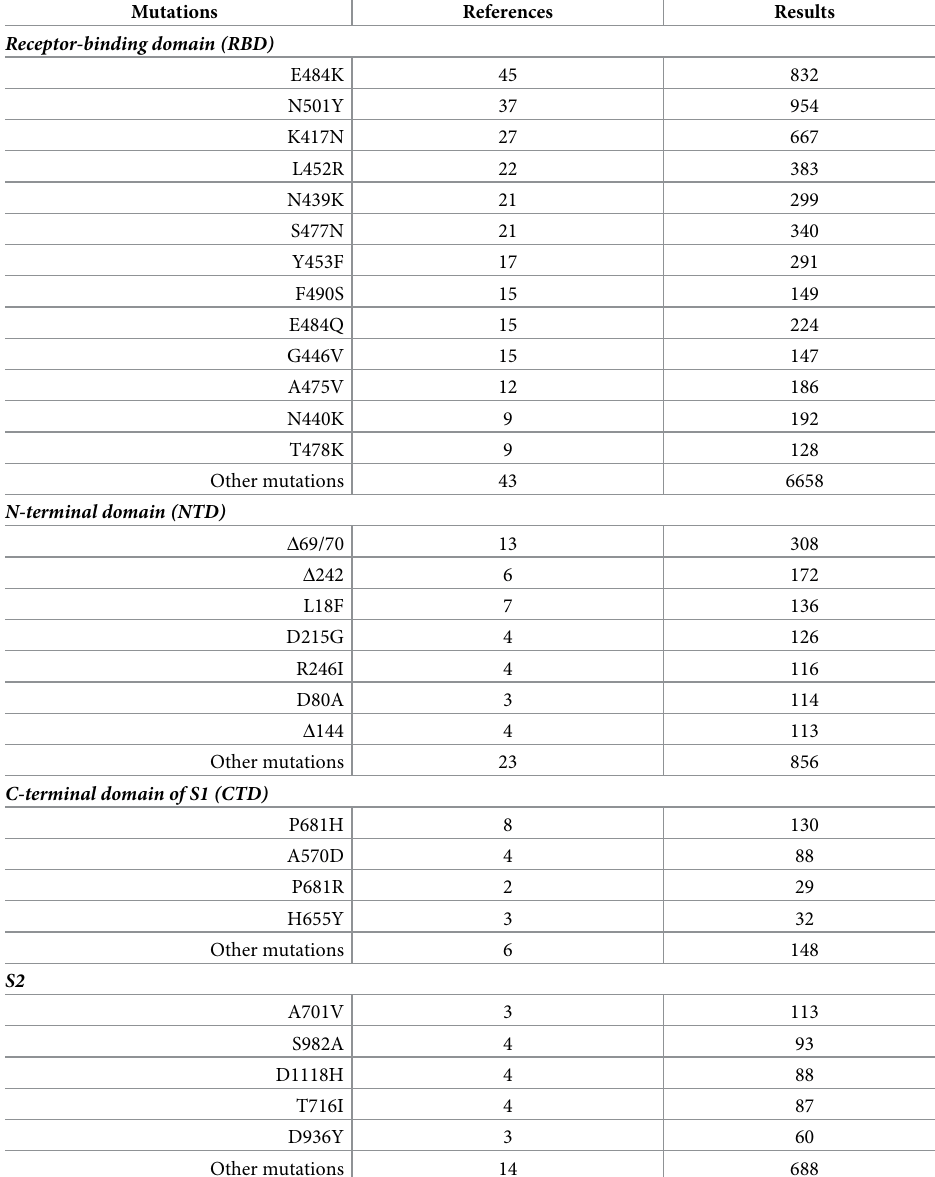
Table 2. Individual SARS-CoV-2 spike mutations for which data are available in CoV-RDB. Mutations